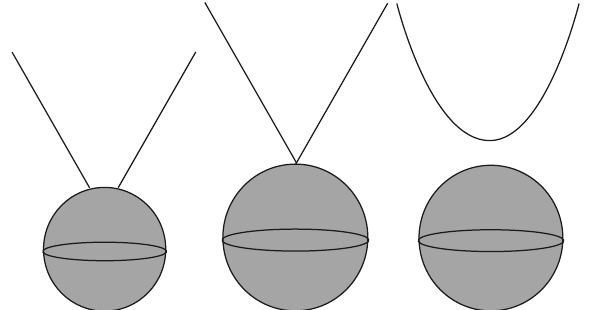
Figure 9: In the vanishing electric field limit, the D-brane (denoted by the curves above) can stay above the black hole (right-most) and fall into the black hole (left-most). These two phases are separated by a critical embedding, corresponding to the middle one.